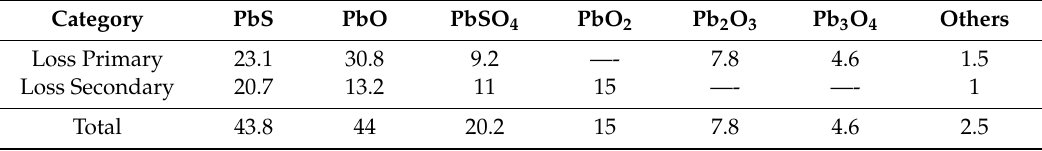
Table 3. The loss of various lead compounds in China’s lead smelting stage in 2017. (Unit: kilo tons). Category PbS